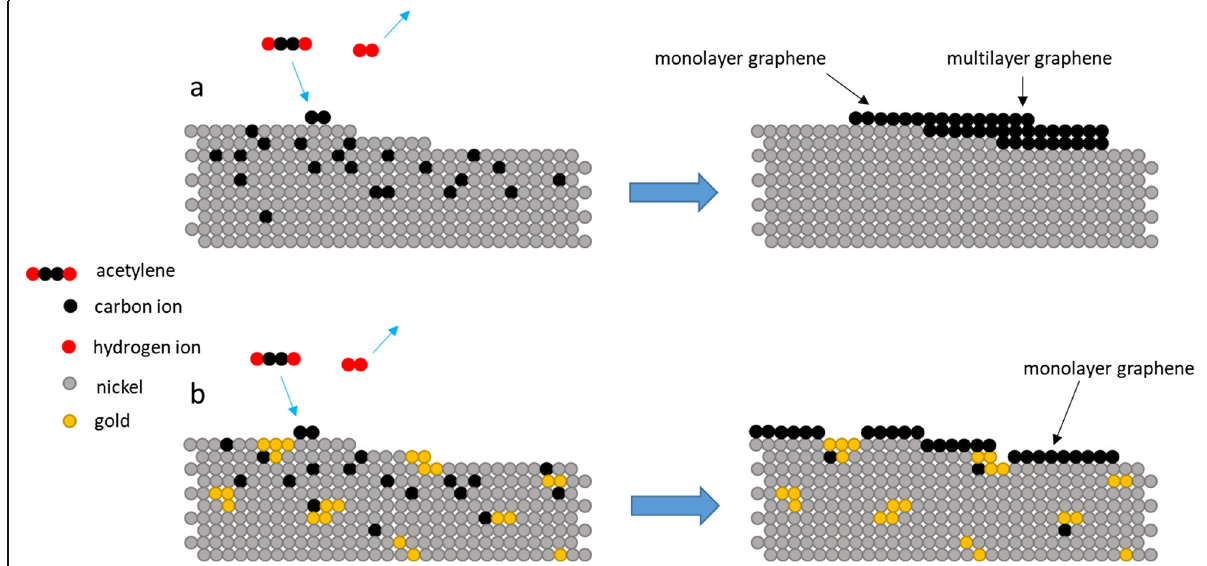
Fig. 3 Schematic diagram of graphene growth on a pure Ni catalyst in which few-layer graphene (FLG) is produced due to uncontrolled C absorption and out-diffusion at high energy sites such as step edges compared to b codeposited Ni-Au synthesis whereby the Au acts as a C absorption limiter as well as reducing high levels of graphene production by blocking nucleation sights such as step